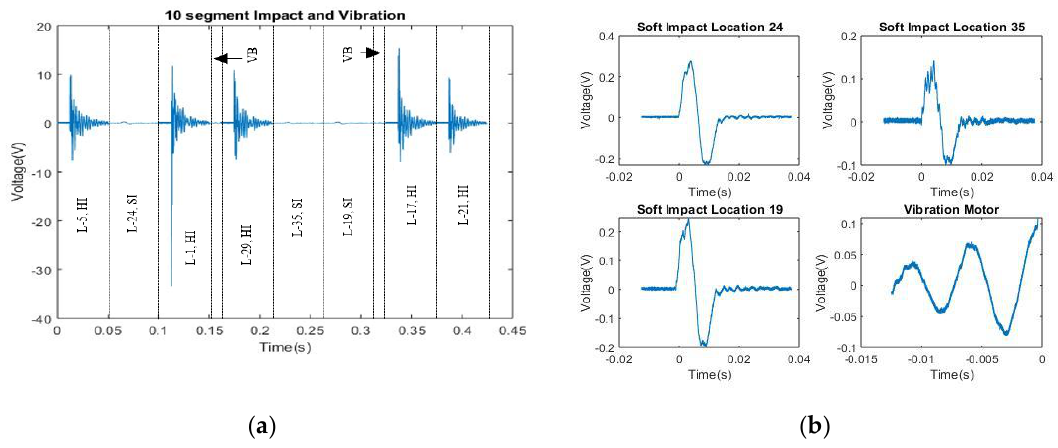
Figure 12 . ( a ) Examples of ten segment signal. VB indicates vibration; ( b ) shows isolated SI’s. Sensors 2020 , 20 , x FOR PEER REVIEW